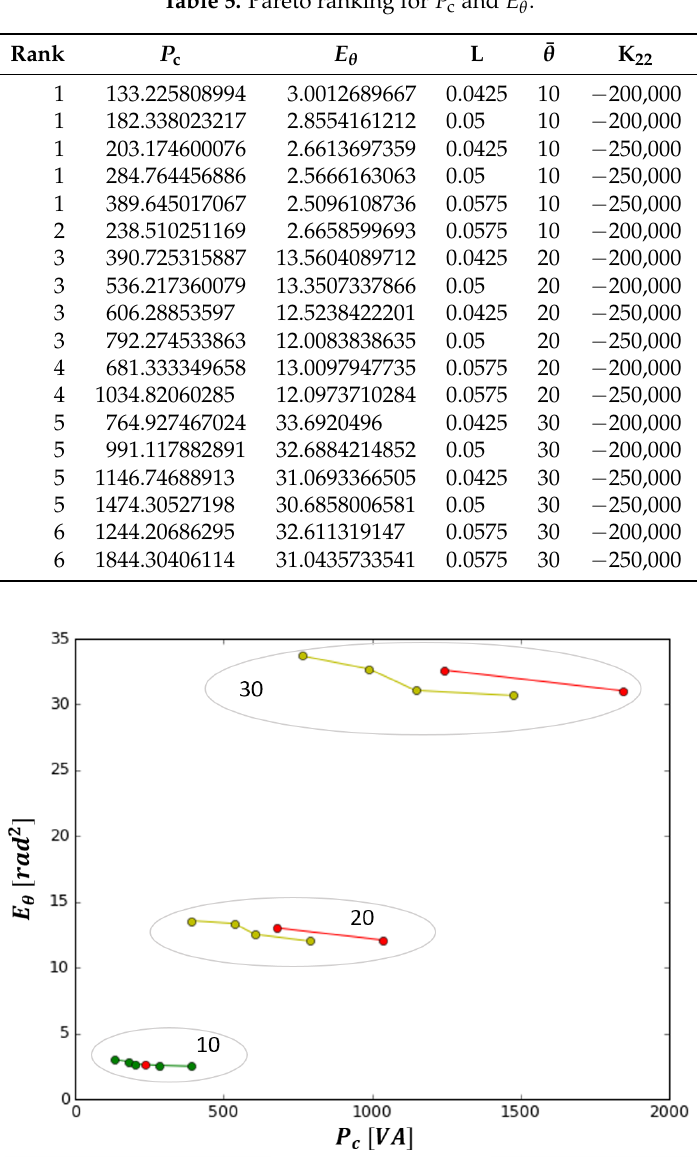
Figure 16. Pareto front for P c and E θ